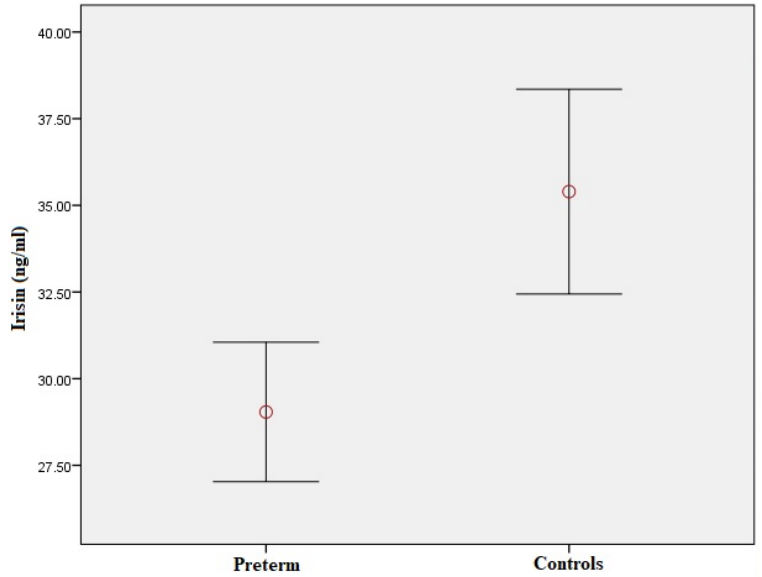
Figure 1. Plasma irisin levels in preterm-born children compared to controls. Red circle represents the mean value of plasma irisin levels in children born prematurely and controls respectively; error bars represent standard error of mean.